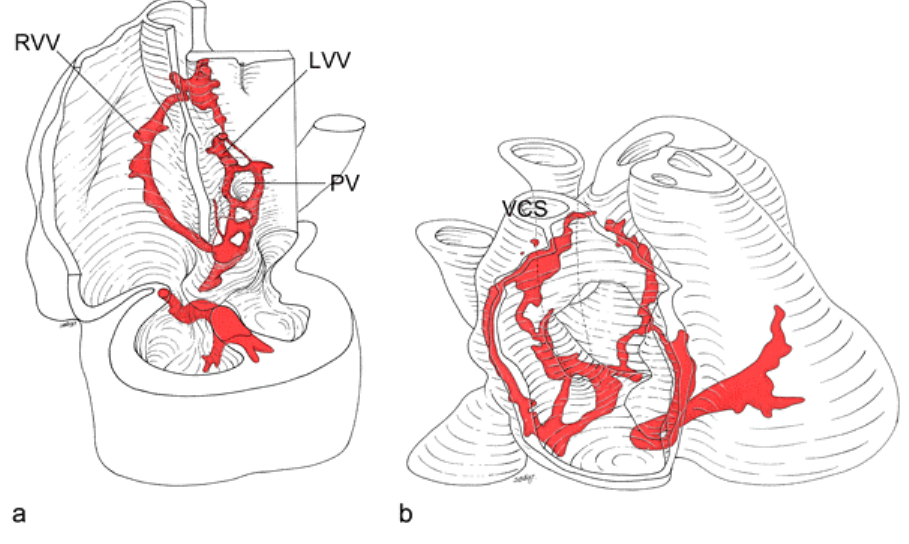
FIGURE 4. HNK1 expression in the human embryo. Explanation see text. LVV, left venous valve; PV, primitive pulmonary vein; RVV, right venous valve; VCS, superior caval vein. Adapted from Blom et